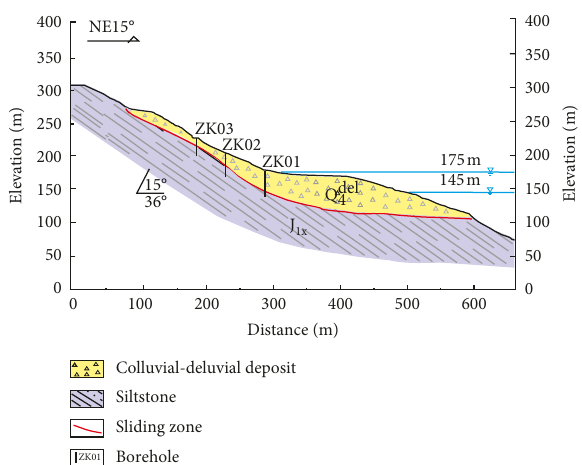
Figure 3: Schematic geological cross section (I–I ′ ) of the Baishuihe landslide.